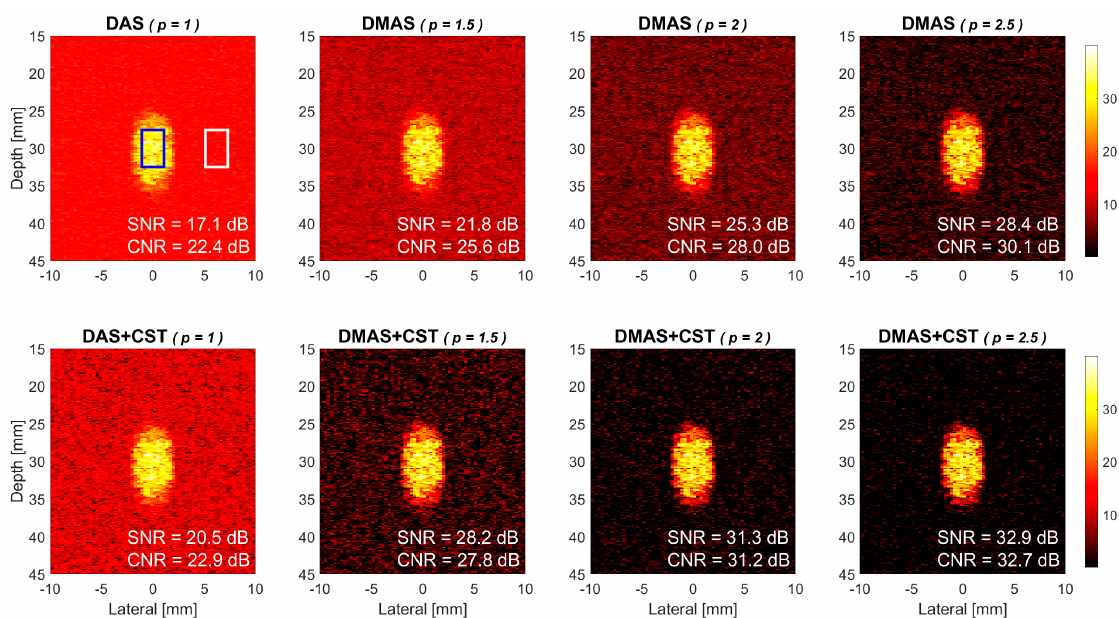
Figure 4. Simulated power Doppler images of flow phantom for DAS beamforming, DMAS beamforming with the p value of 1.5, 2.0 and 2.5, respectively from left to right. Seven PW transmit angles are used (i.e., [ − 7.5° − 5° − 2.5° 0° +2.5° +5° +7.5°]). Upper panels: without the CST technique. Lower panels: with the CST technique.